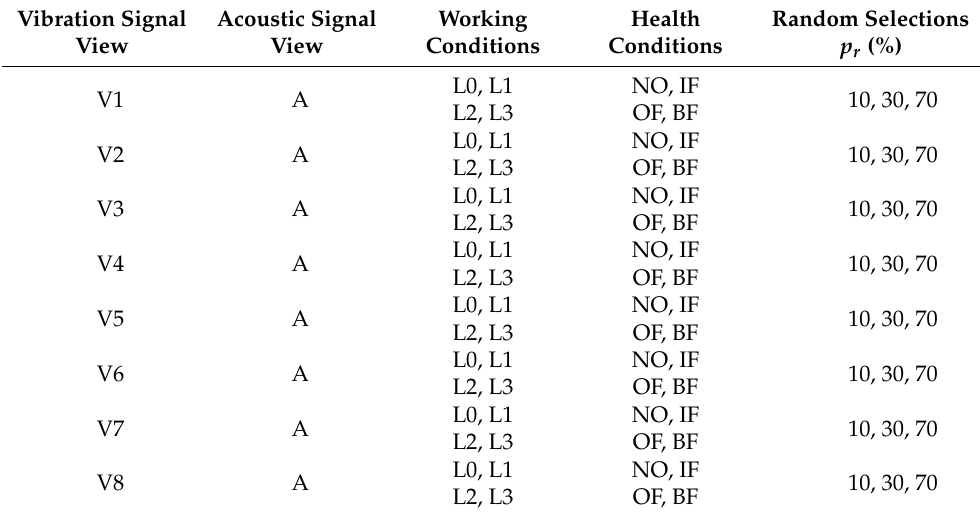
Table 2. Description of the experimental